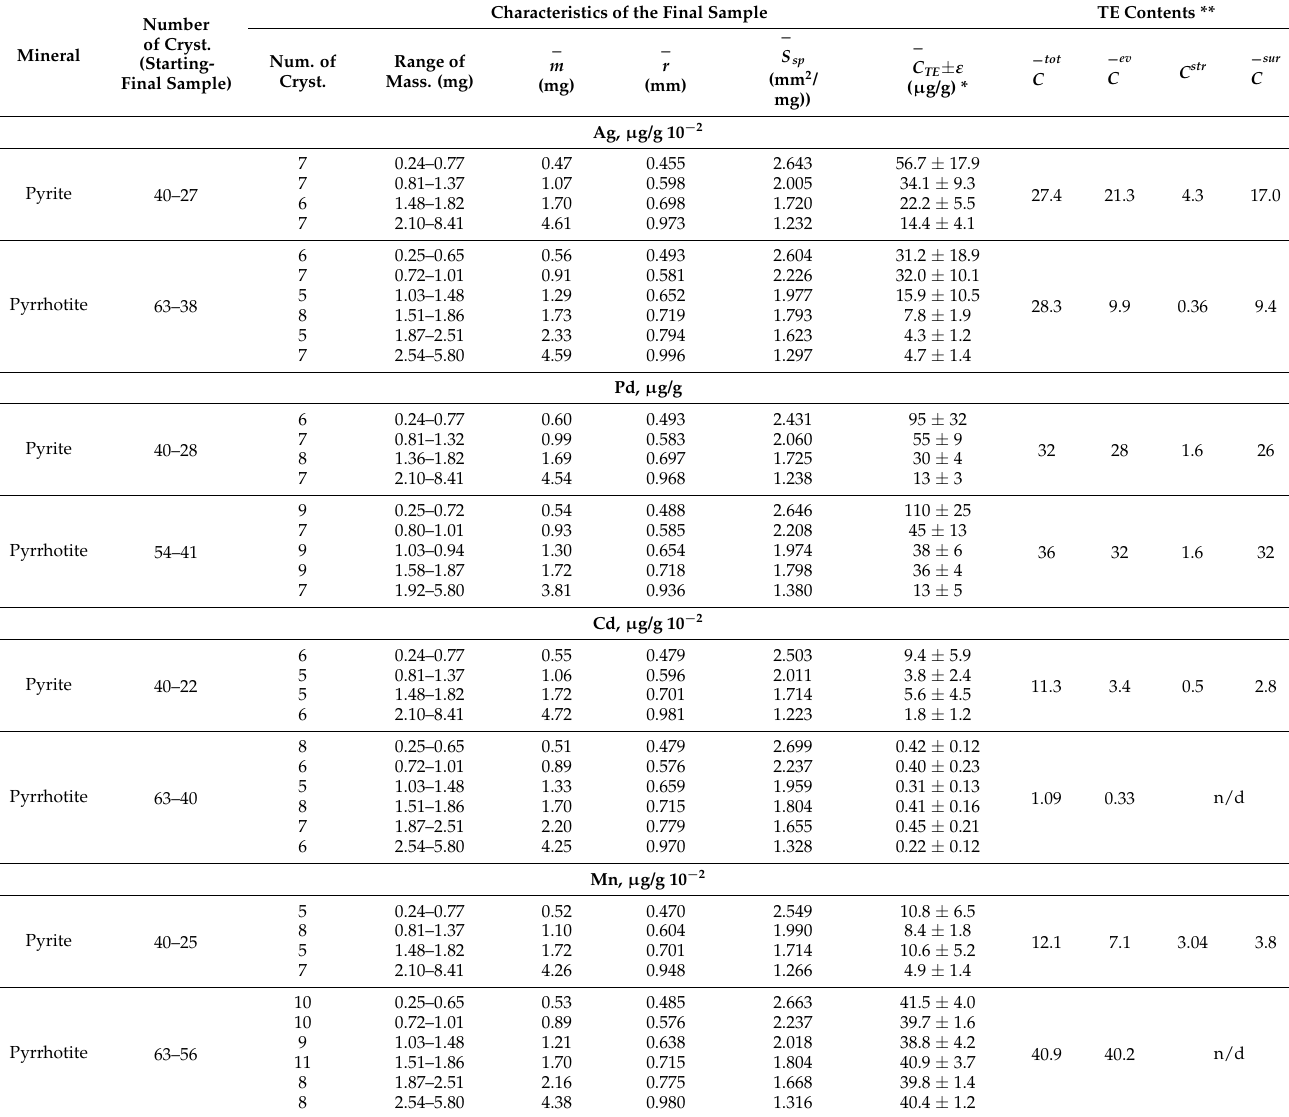
Table 1. Results of the AAS–ADSSC analysis of single crystal size selections of coexisting pyrite and pyrrhotite obtained in hydrothermal system at 400 ◦ C and 1